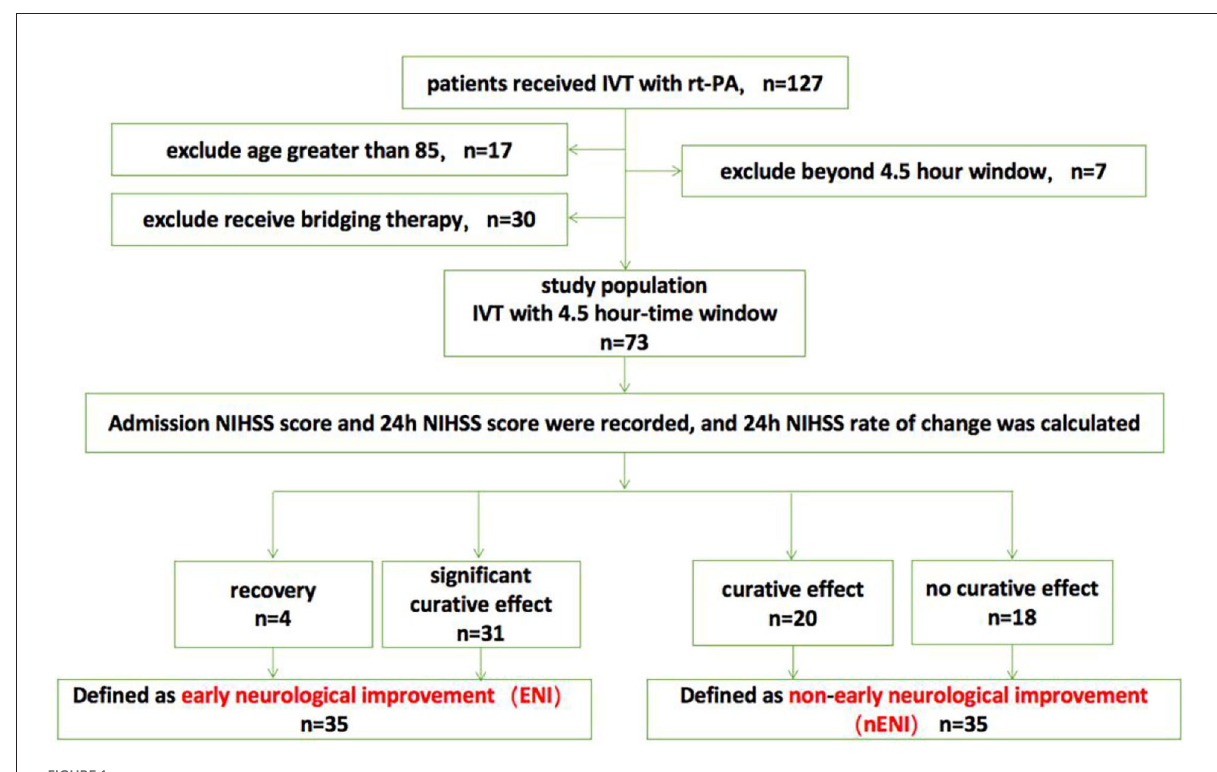
FIGURE1 Flow chart of the study population. IVT, intravenous thrombolysis; NIHSS, National Institutes of Health Stroke